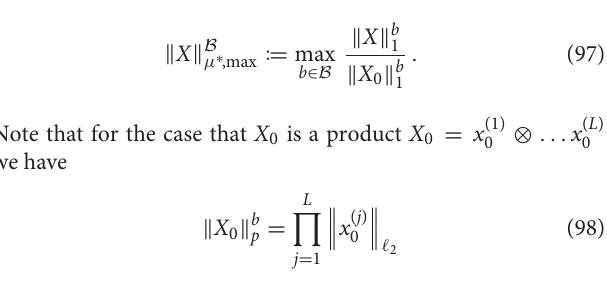
FIGURE 3 | Observed average of the statistical dimension (17) for a product signal X 0 the bipartitions corresponding to (i) the TT decomposition, (ii) the HOSVD decomposition, (iii) B 2 : B Square deal : ( 1,2 ). The statistical dimension δ corresponds to the critical number of measurements where the phase transition in the reconstruction success = { } probability occurs. The plots suggest that for the B 3 -max-norm the number of measurements scales roughly as twice the lower bound given by (100). For the numerical implementation, the SDP (64) has been used. The error bars indicate the unbiased sample standard deviation. The numerics has been implemented with Matlab+CVX+SDPT3.